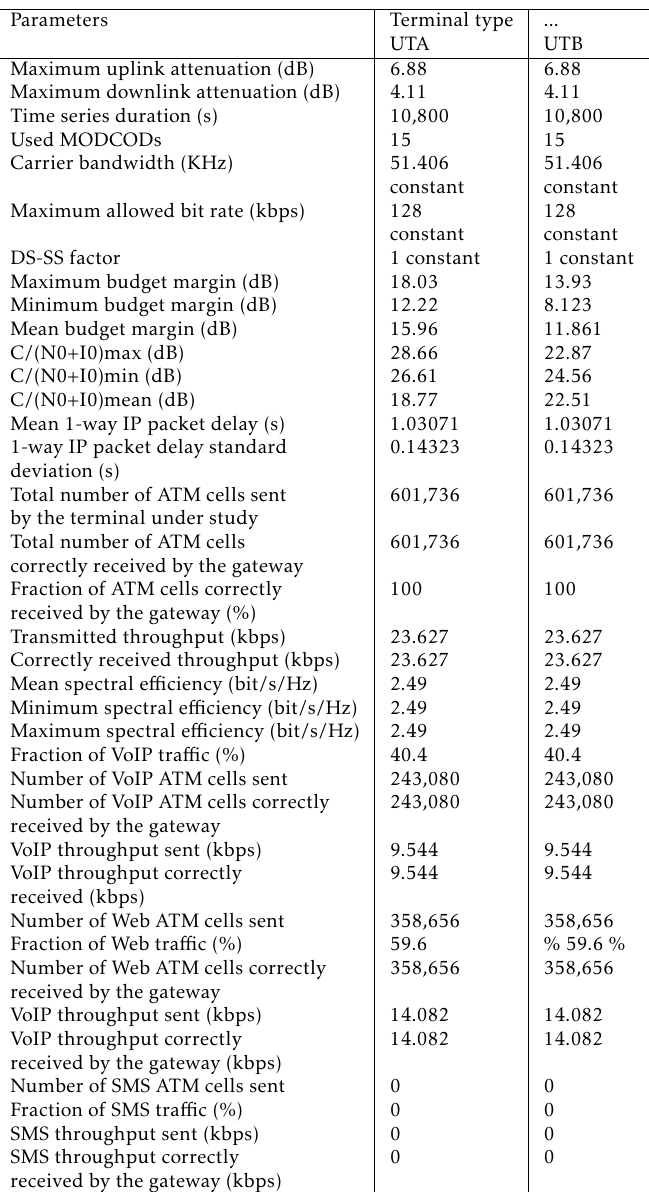
Table 1. Return link performance report for UTA and